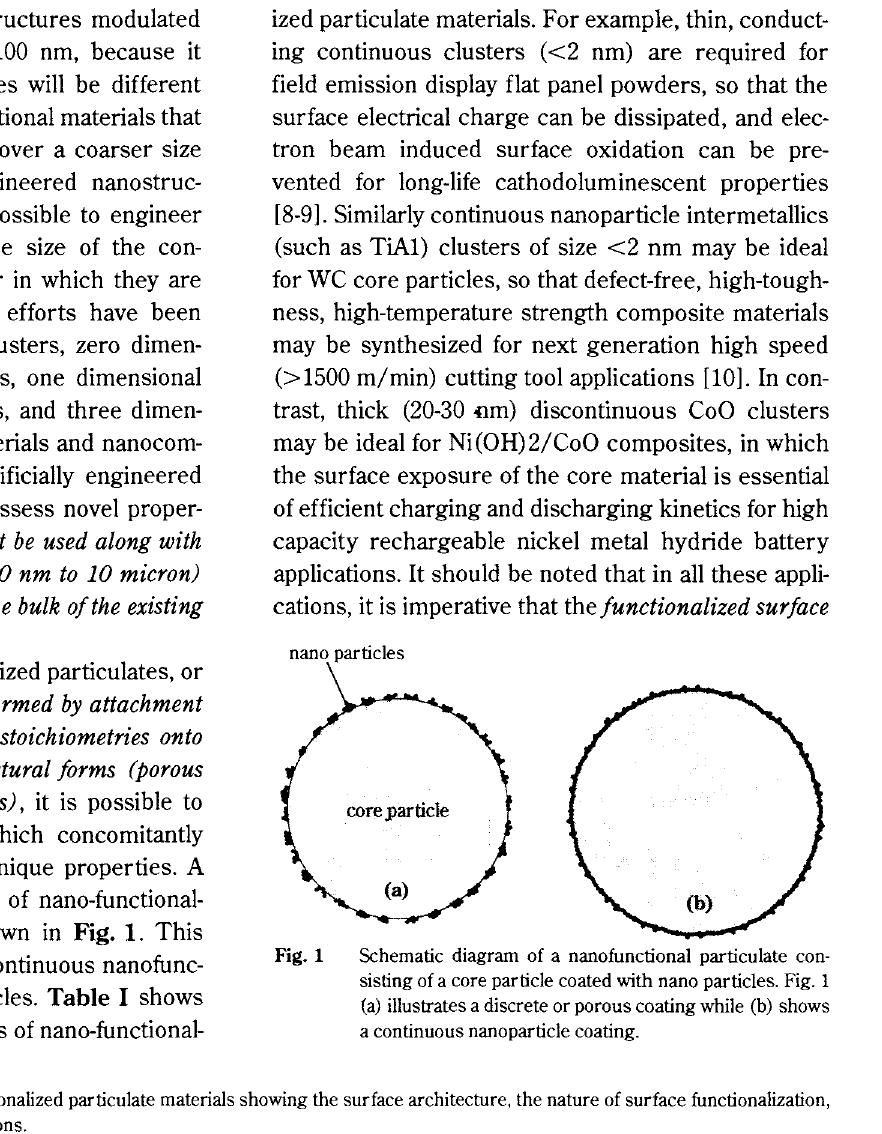
Table I Various Examples of nano functionalized particulate materials showing the surface architecture, the nature of surface functionalization, and potential desirable